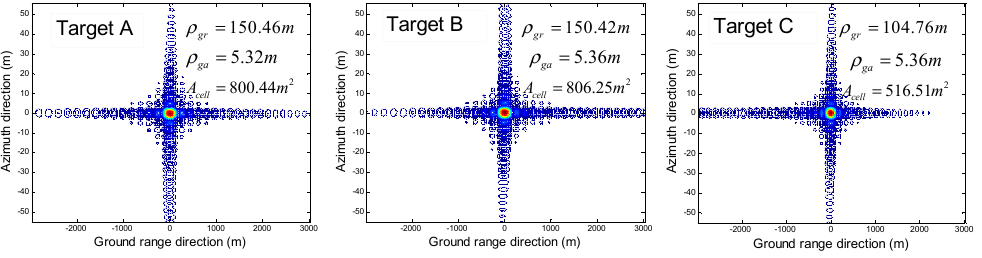
Figure 8. Imaging simulation of the forward quasi-specular bistatic. ( a ) Sketch; ( b ) Imaging result.